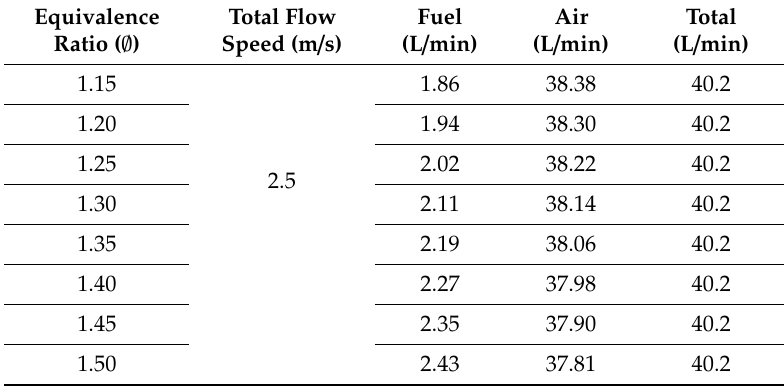
Table 1. Fuel-rich operating conditions for the combustion experiment.